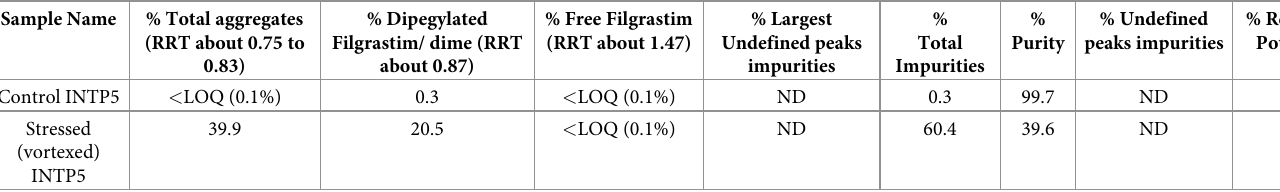
Table 9. In vitro bioassay and SEC-HPLC data of forced aggregated